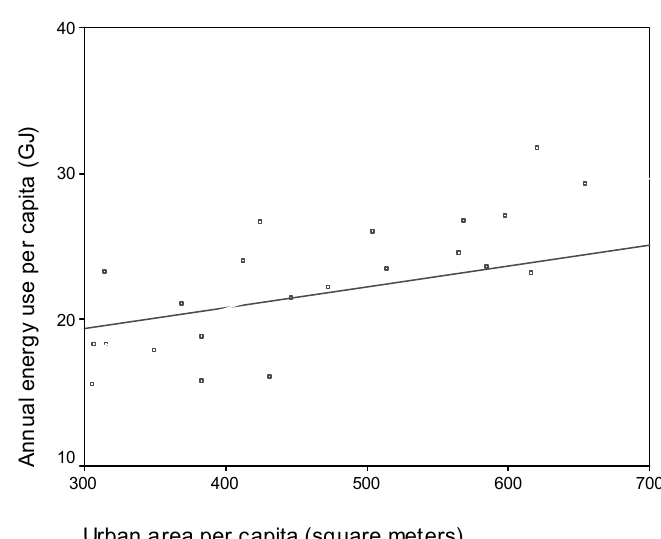
Figure 3. Annual energy use per capita for transport (GJ) in Nordic cities with differences in urban area (square meters) per inhabitant. The regression line shows the relationship when controlling for a number of demographic, socio-economic and other urban form factors 2 . Level of significance for the controlled relationship: 0.032.